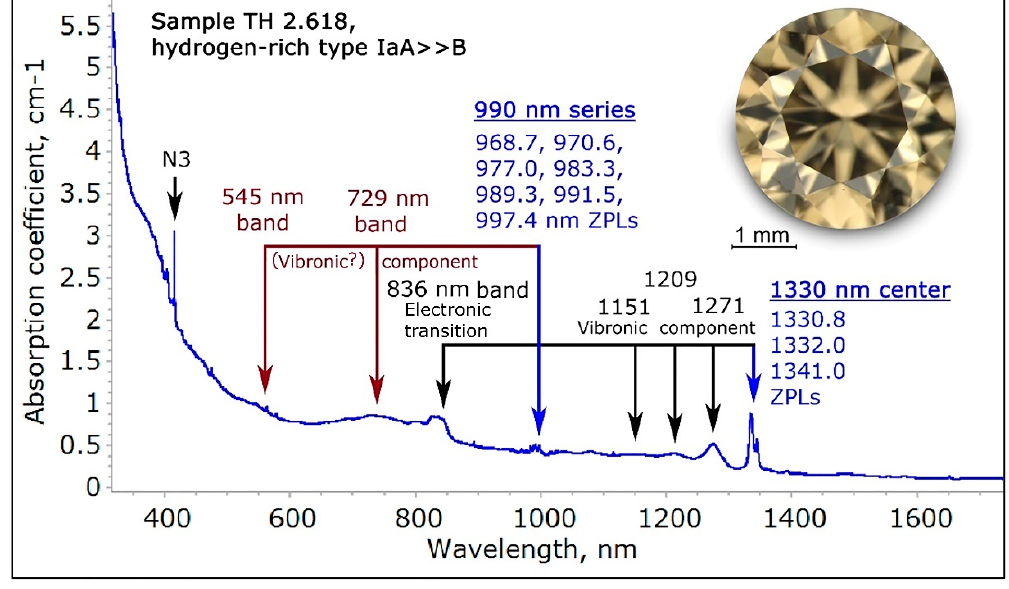
Figure 20. The extended low temperature UV-Vis-NIR spectrum covering the range to 1700 nm of a type Ia hydrogen-rich yellowish brown diamond. The figure shows the correlation between the complex absorptions in the 500 to 850 nm range with the 1330 nm center and the 990 nm series. The complex broad bands are proposed to relate to these two spectral features, and some represent vibronic components of these centers.